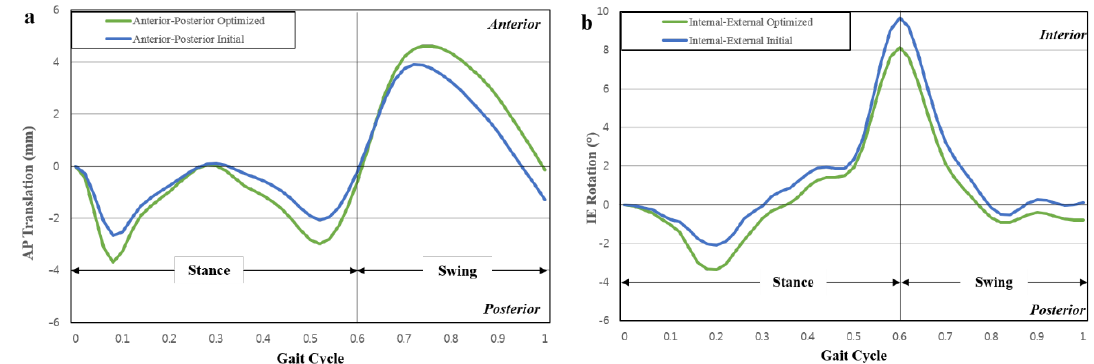
Figure 6. Comparison of kinematics of initial and optimized conformities in customized posterior-stabilized total knee arthroplasty (PS-TKA) under the gait cycle condition: ( a ) AP translation in 0 and 5 million cycles; ( b ) IE rotation in 5 million cycles.